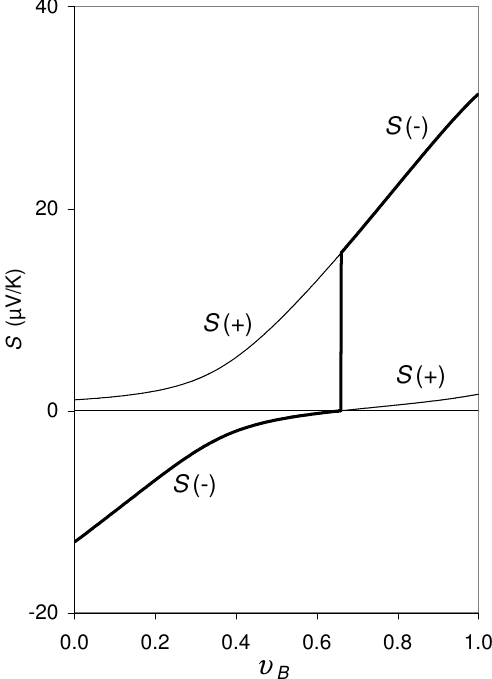
Figure 2. S ( − ) (bold line) and S (+) (thin line) vs. υ B calculated by Equations (2)–(13) for a = − 13.0 µ V/K, S 0 = + 1.5 µ V/K, κ = 8.5 mW/cmK, and hypothetical composite with S 0 e , A B A κ e , B = 12.7 mW/cmK (corresponding to n = 10 22 cm − 3 and p = 2 × 10 22 cm − 3 and T = 300 K, where d µ / dT , Equation (10), is calculated for ∂ E C , A / ∂ T = ∂ E V , B / ∂ T = ∂ϕ i / ∂ n i = 0).